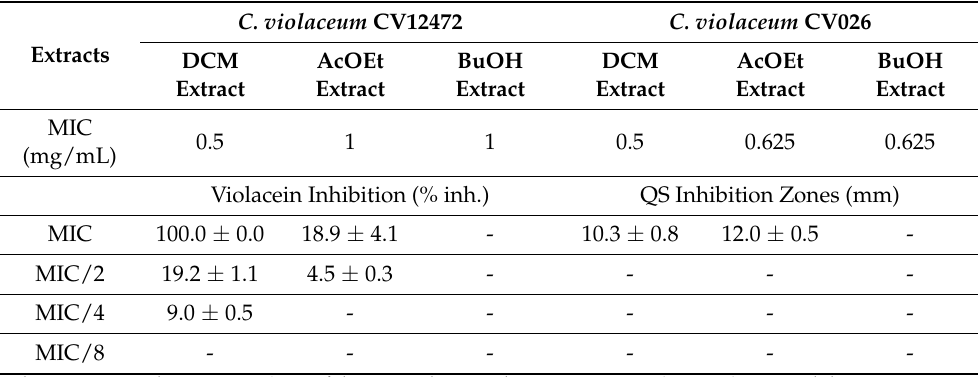
Table 2. Violacein inhibition percentage and quorum-sensing inhibition (diameter zones) of C. nepeta extracts.